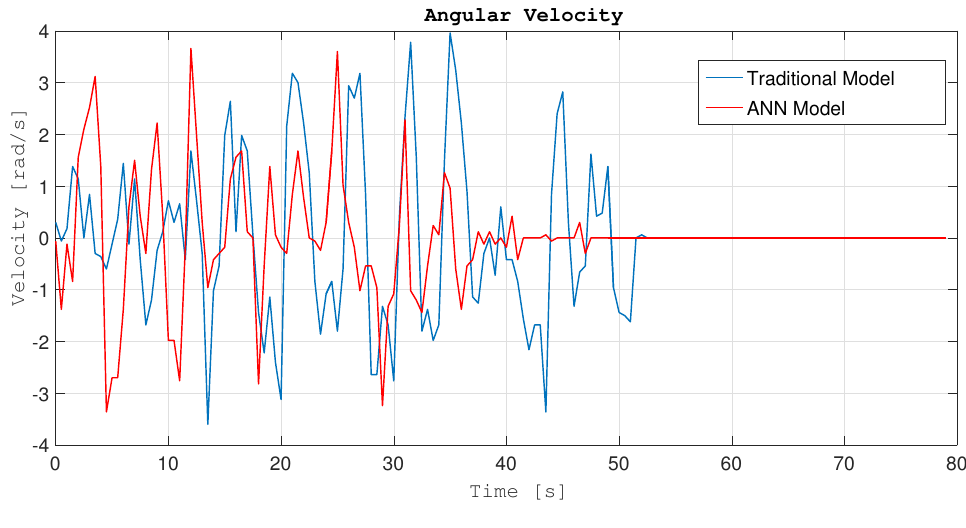
Figure 19. Angular velocities.